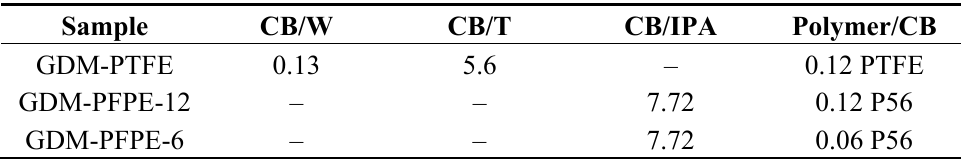
Table 1. Ink composition (all the numbers refers to w/w